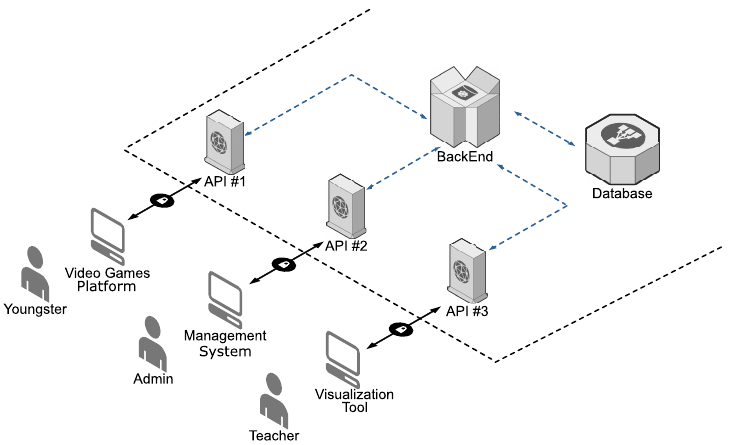
Fig. 4. Software architecture of the system designed in YoungRes project. This ¯gure shows the di®erent components of the system, the di®erent users that will work with the system and the di®erent subsystems that these users will interact